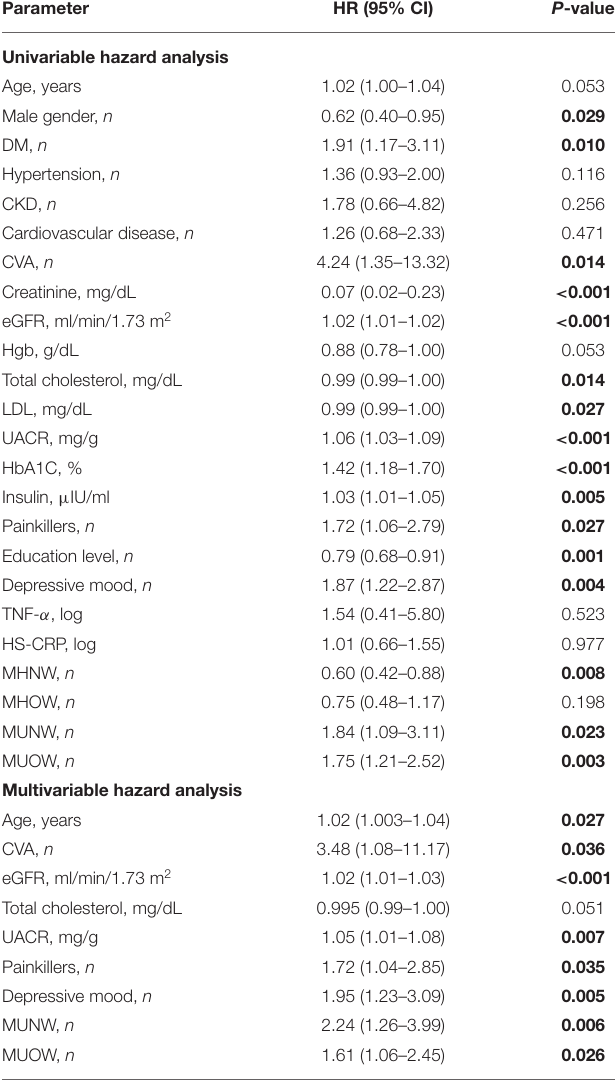
TABLE 4 | Univariate Cox regression analysis for the risk of RKFD according to baseline characteristics.